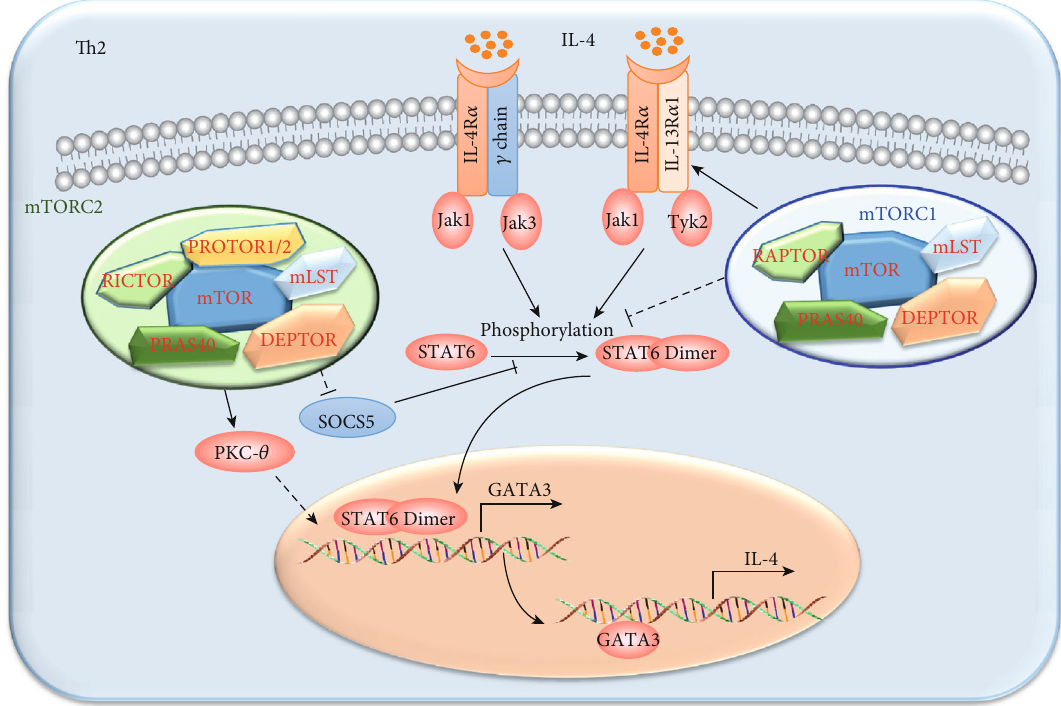
Figure 4: The regulation of mTORC1 and mTORC2 on Th2 cell di ff erentiation. Th2 cell di ff erentiation is regulated mainly by mTORC2. mTORC2 positively regulates the expressions of GATA3 and IL-4 through inhibiting the expression of SOCS5, which could inhibit the activation of STAT6. Meanwhile, mTORC2 positively regulates Th2 cell di ff erentiation in a PKC- θ -dependent manner, while the detailed mechanism has not been illuminated. mTORC1 negatively regulates Th2 cell di ff erentiation through modulating the activation of STAT6, while the detailed mechanism was not clari fi